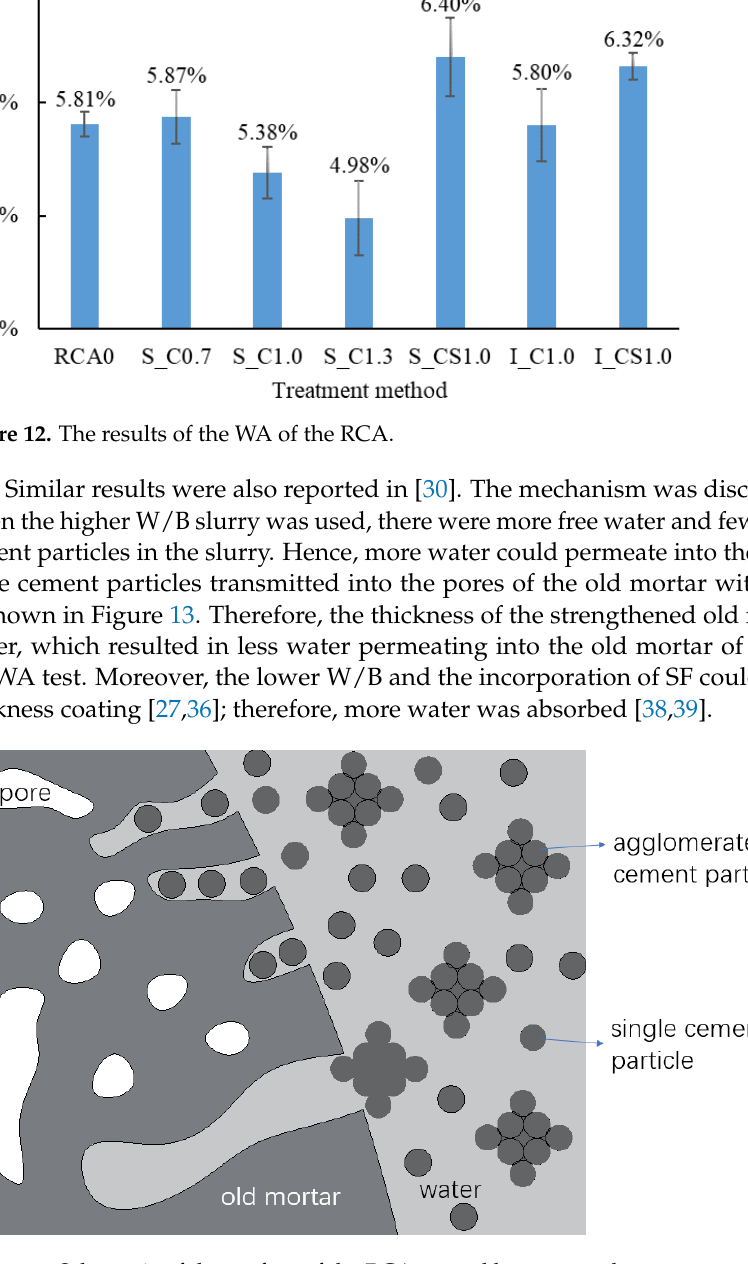
Figure 13. Schematic of the surface of the RCA treated by cement slurry.